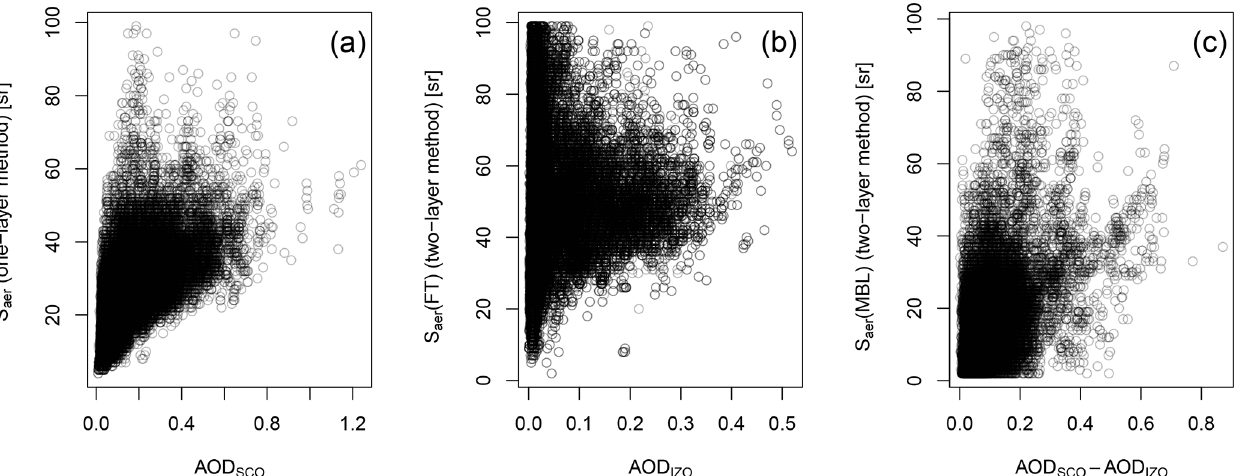
Figure 8. Lidar ratio for (a) one-layer inversion, (b) two-layer inversion for the FT and (c) two-layer inversion for the MBL, all of them against AOD.